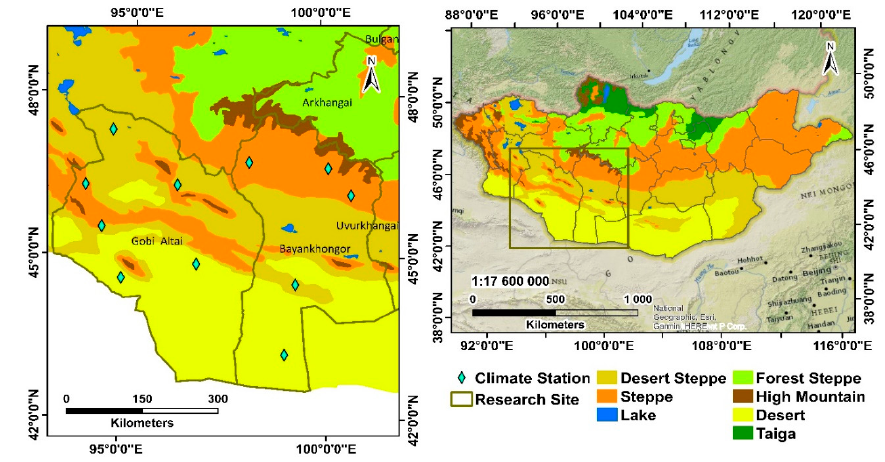
Figure 1. Location of meteorological stations for NDVI measurements in Gobi-Altai and Bayankhongor provinces. Data are sourced from the Institute of Meteorology and Hydrology of Mongolia. Table 2. Meteorological stations with information on location, and vegetation zones.